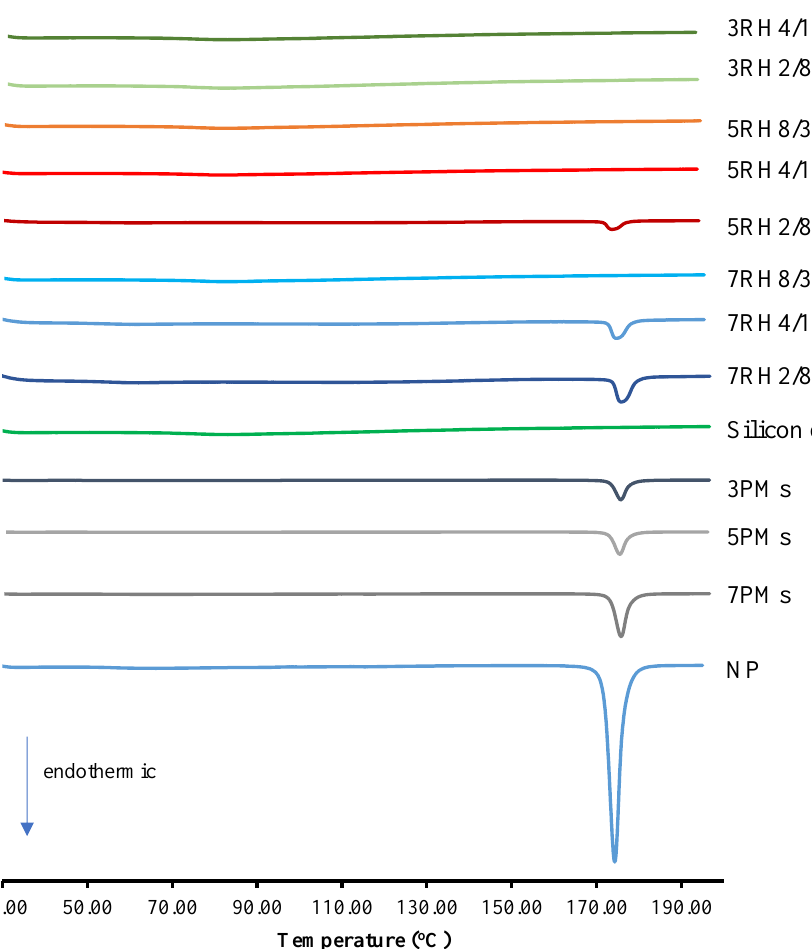
Figure 2. Differential scanning calorimetry (DSC) thermograms of the dry MIPEs and NP powder. The 3PMs, 5PMs, and 7PMs were physical mixtures (PMs) of 8% surfactant and 32% oil, with NP contents of 0.3%, 0.5%, and 0.7%, respectively.